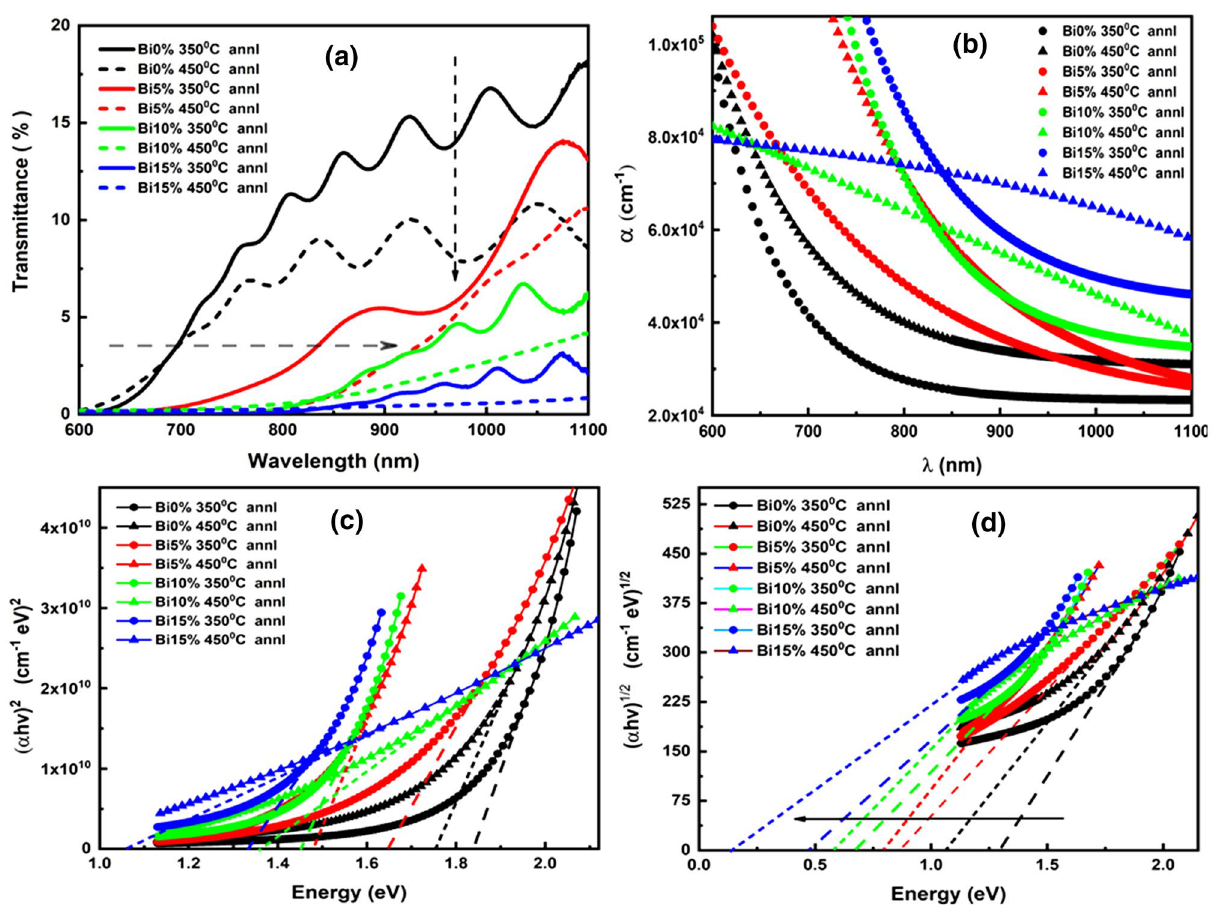
Figure 5. ( a ) Transmittance spectra of annealed the Bi x In 35-x Se 65 films ( b ) Absorption coefficient (α) vs wavelength spectra for the annealed Bi x In 35-x Se 65 films ( c ) Direct optical bandgap calculation for the annealed Bi x In 35-x Se 65 films ( d ) Indirect bandgap calculation for the annealed Bi x In 35-x Se 65